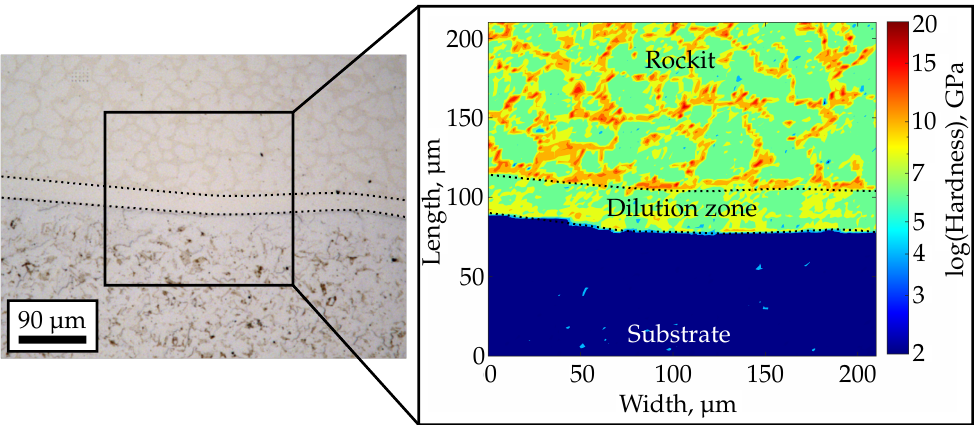
Figure 6. Nano-hardness mapping ( right ) with position of the measuring field ( left ) on the hybrid Rockit ® —ASTM A572